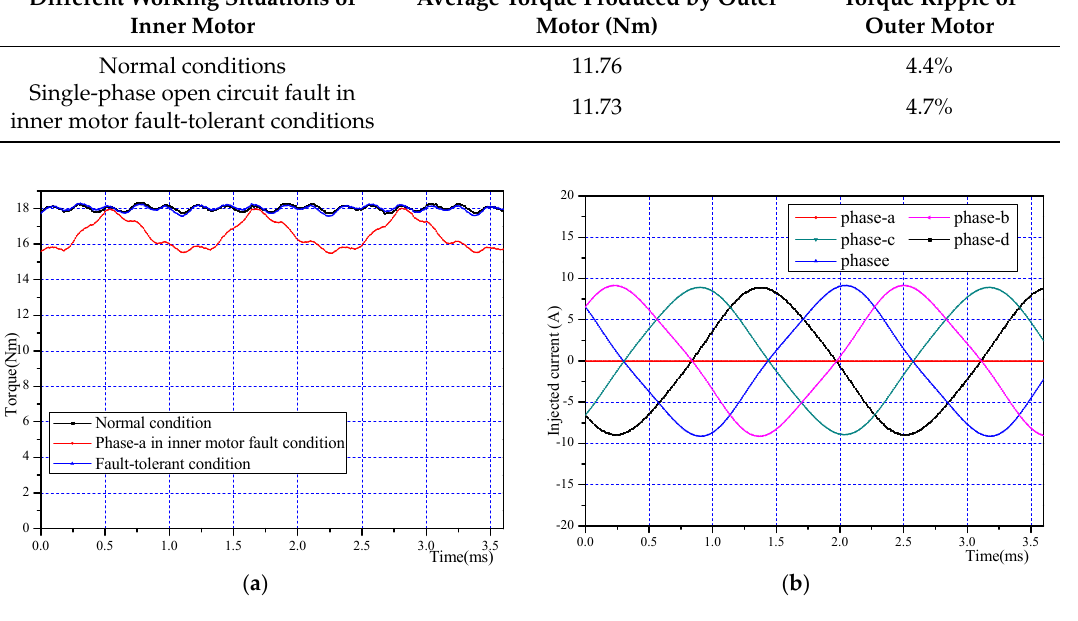
Figure 15. The motor operates under single ‐ phase open circuit in the inner motor condition: ( a ) electromagnetic torque obtained by FEA; ( b ) the injected fault ‐ tolerant currents of the inner motor.